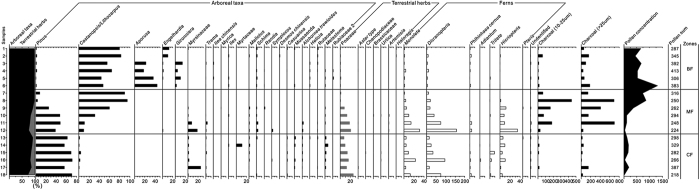
Surface soil pollen diagram in natural communities CF, MF, and BF at the Dinghushan Natural Reserve in South China.Note: BF = broadleaved forest; MF = pine and broadleaved mixed forest; CF = coniferous forest. The Y axis on the left indicates the sample number.